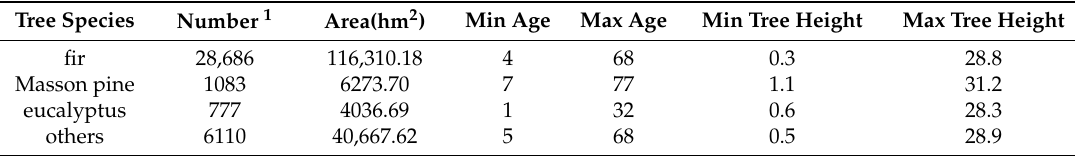
Table 2. Statistics of basic stand factors of forest resource sub-compartment in Rongshui County, Guangxi Zhuang Autonomous Region Statistics of subcompartment tree